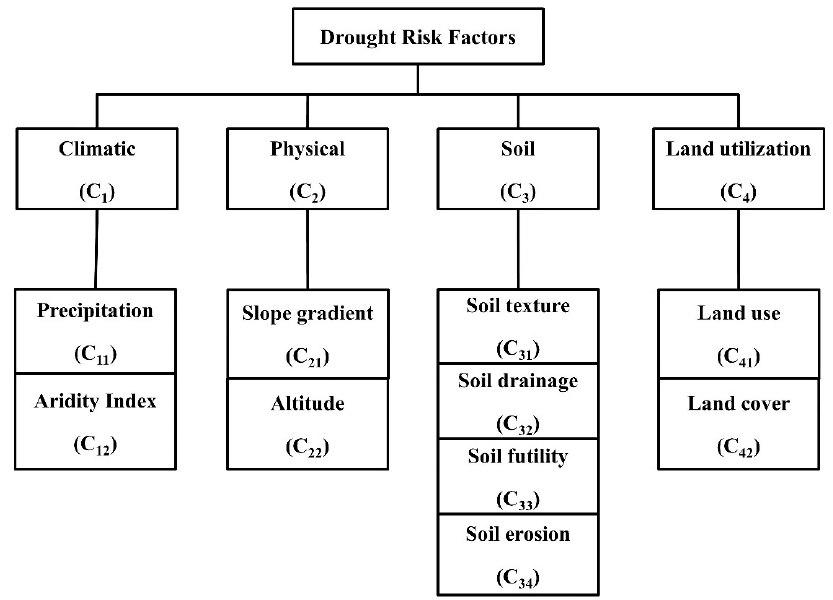
Figure 2. The hierarchy model of the drought risk evaluation of the Upper Phetchaburi River Basin (UPRB).